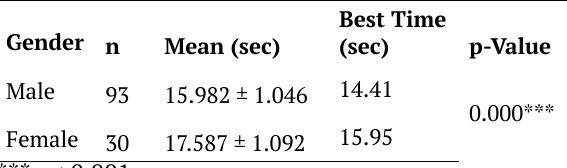
Table 2. T-Test results of IAT mean’ difference of men and